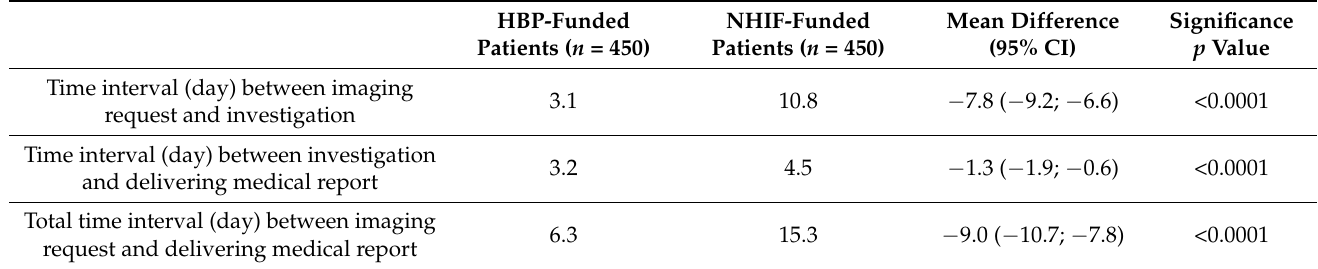
Table 1. Time intervals for steps of CT/MRI imaging process in HBP-funded vs. NHIF-funded patients with definitive or suspected diagnosis of malignancies (entire cohort).